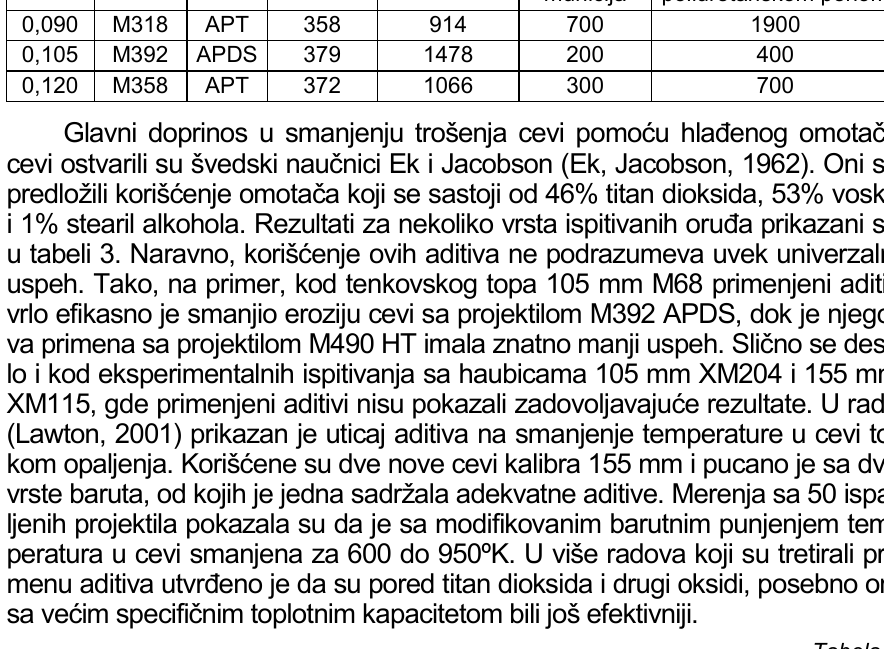
Životni vek cevi [broj projektila]